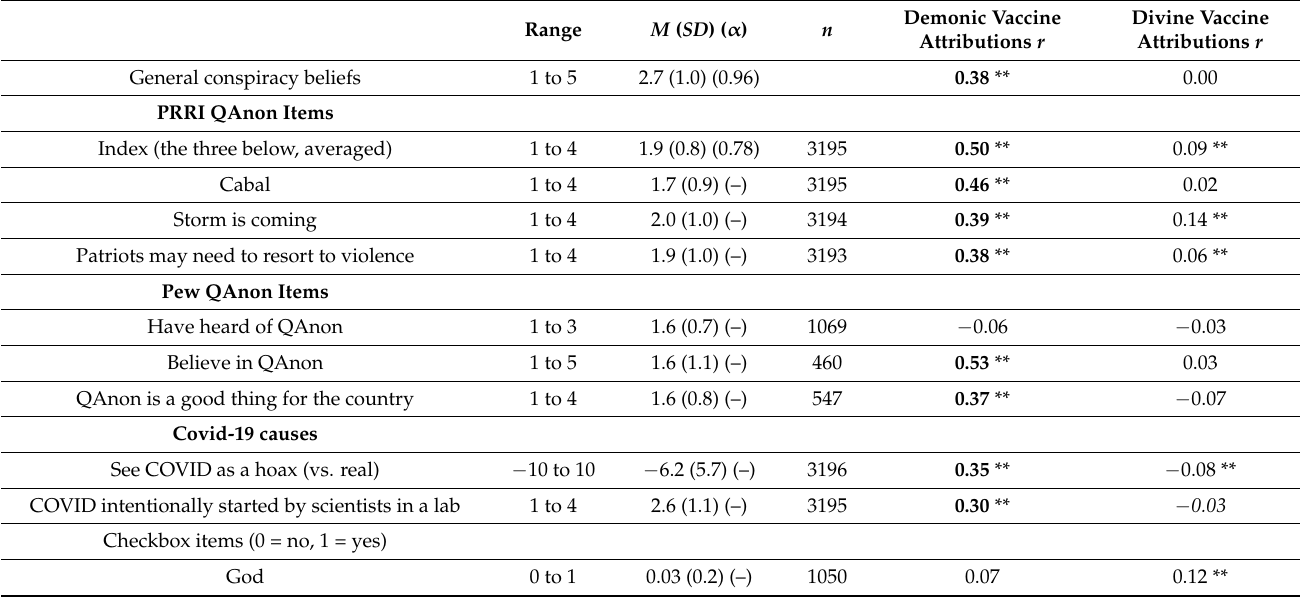
Table 2. QAnon and Conspiracy Beliefs: Descriptive Statistics and Correlations with Demonic and Divine Attributions about